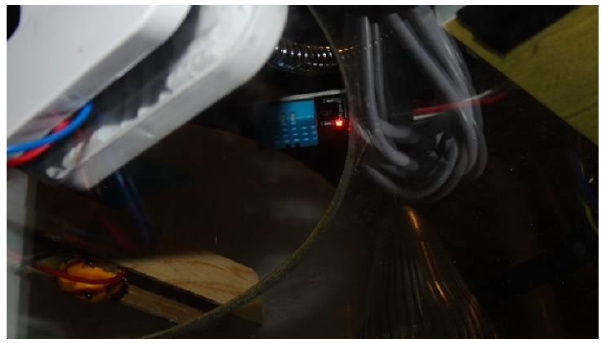
Figure 3. DHT 11 temperature and humidity